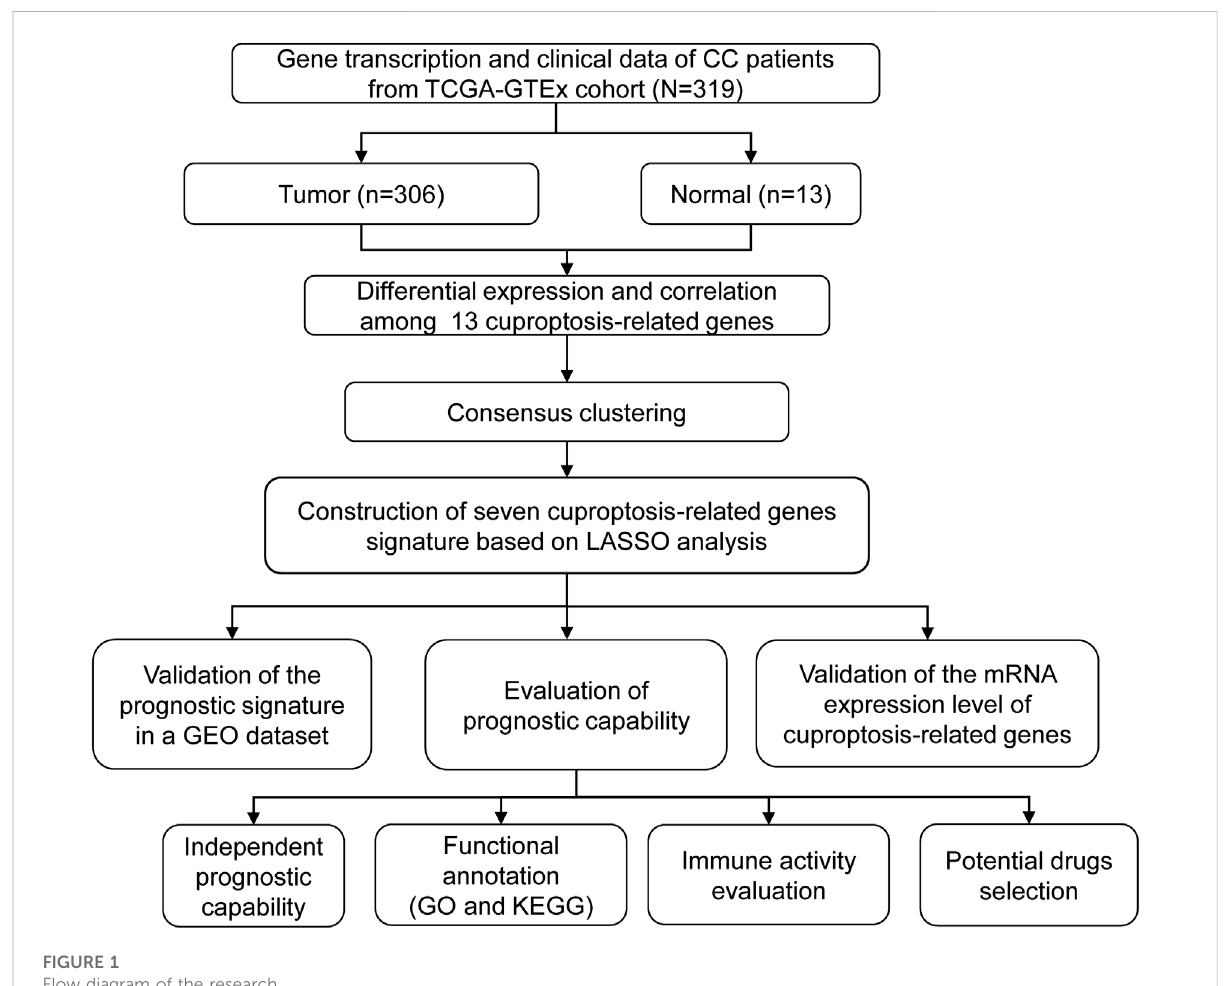
FIGURE 1 Flow diagram of the research.